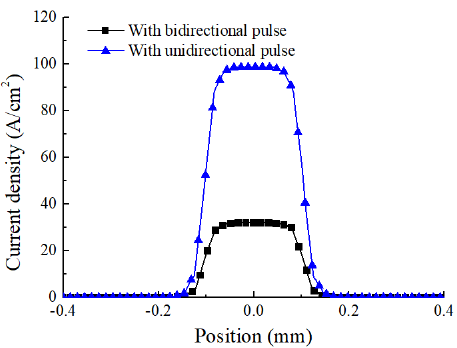
Figure 5. The current density distribution with different machining